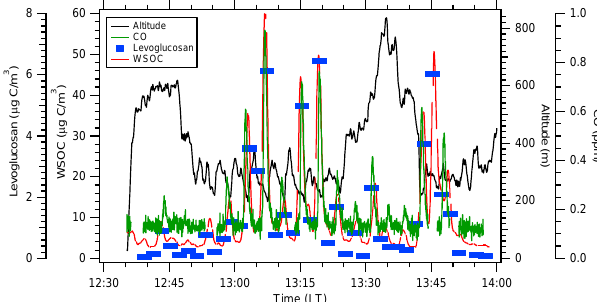
Figure 2. Time series of 1s altitude along with absolute CO, lev- oglucosan, and WSOC from